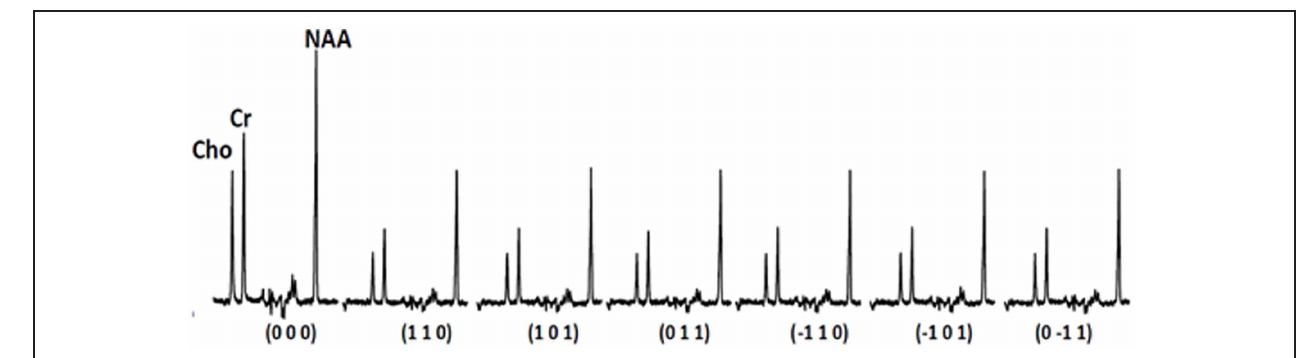
FIGURE 2 | Sample spectra acquired during the diffusion